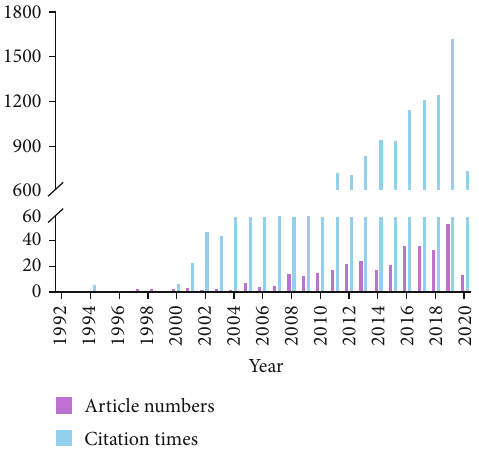
Figure 1: Number of publications and citations for S1P manuscripts produced between 1992 and 2020, per